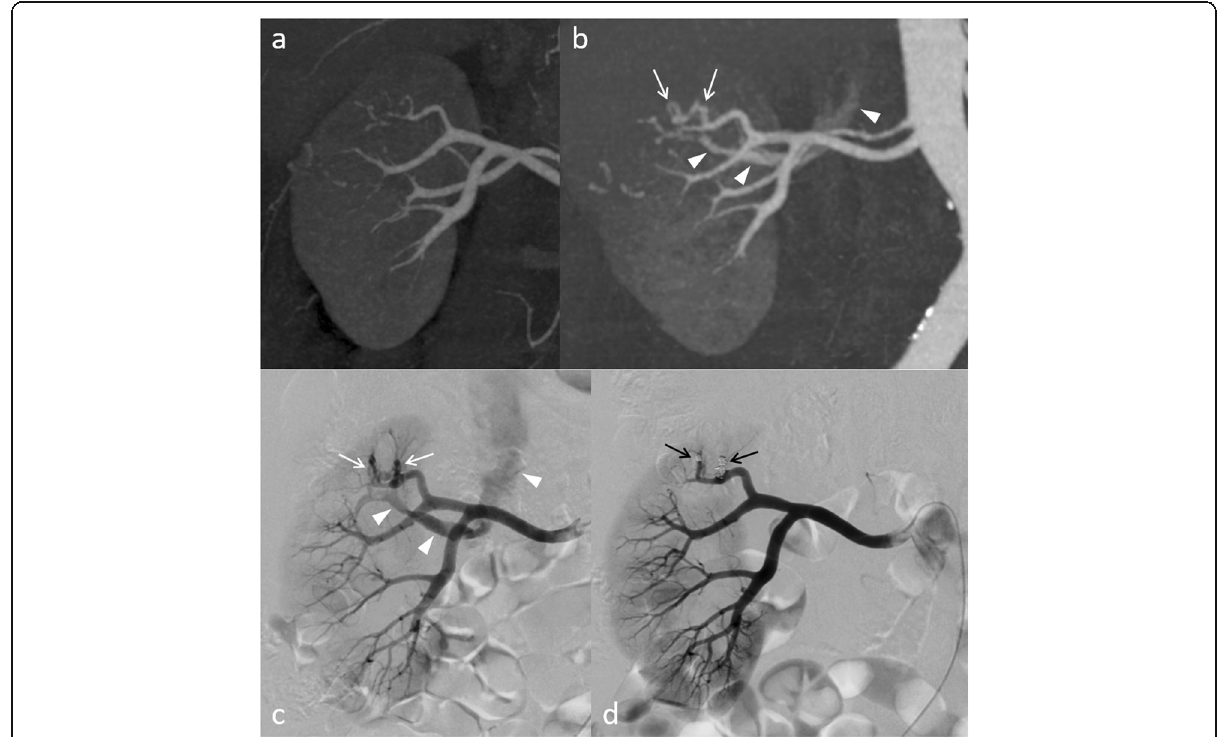
Fig. 3 A case of two newly appearing arteriovenous fistulas (AVFs), with symptoms, in a 67-year-old woman. a No abnormal finding observed on early postoperative contrast-enhanced CT on postoperative day (POD) two. b Two AVFs (arrows) with early venous return (arrowheads) appear on CT obtained on POD 19, with hematuria after discharge. c , d Angiography showing the two AVFs (white arrows) successfully embolized using microcoils (black arrows), with early venous return (arrowheads) disappearing on POD